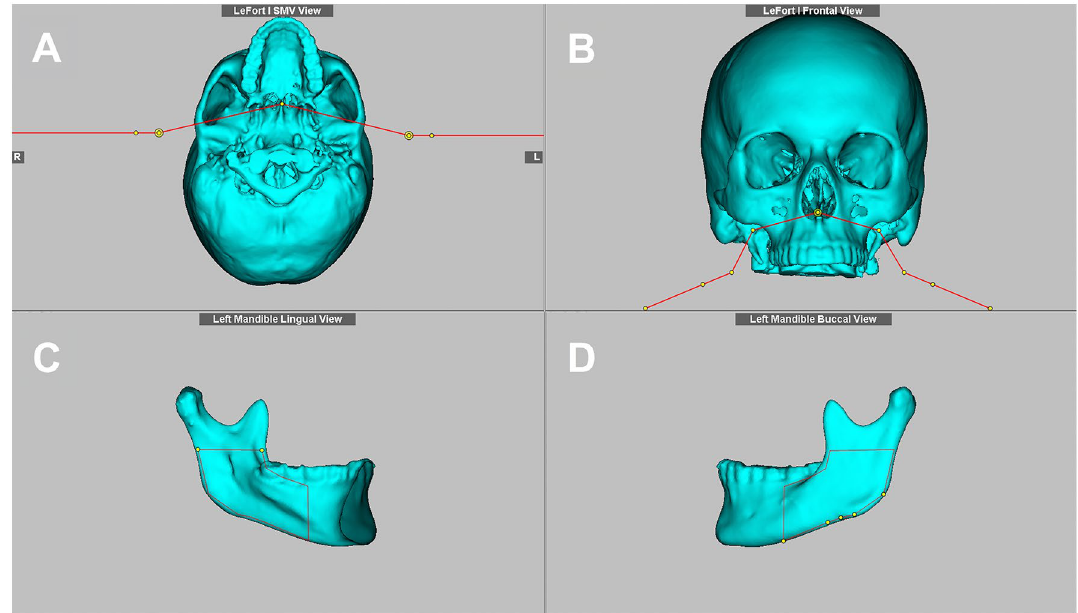
Figure 2. Osteotomy lines (red) for LeFort I from a submentovertex ( A ) and frontal view ( B ), and for mandibular sagittal split from a lingual ( C ) and buccal view ( D ) using Dolphin imaging.